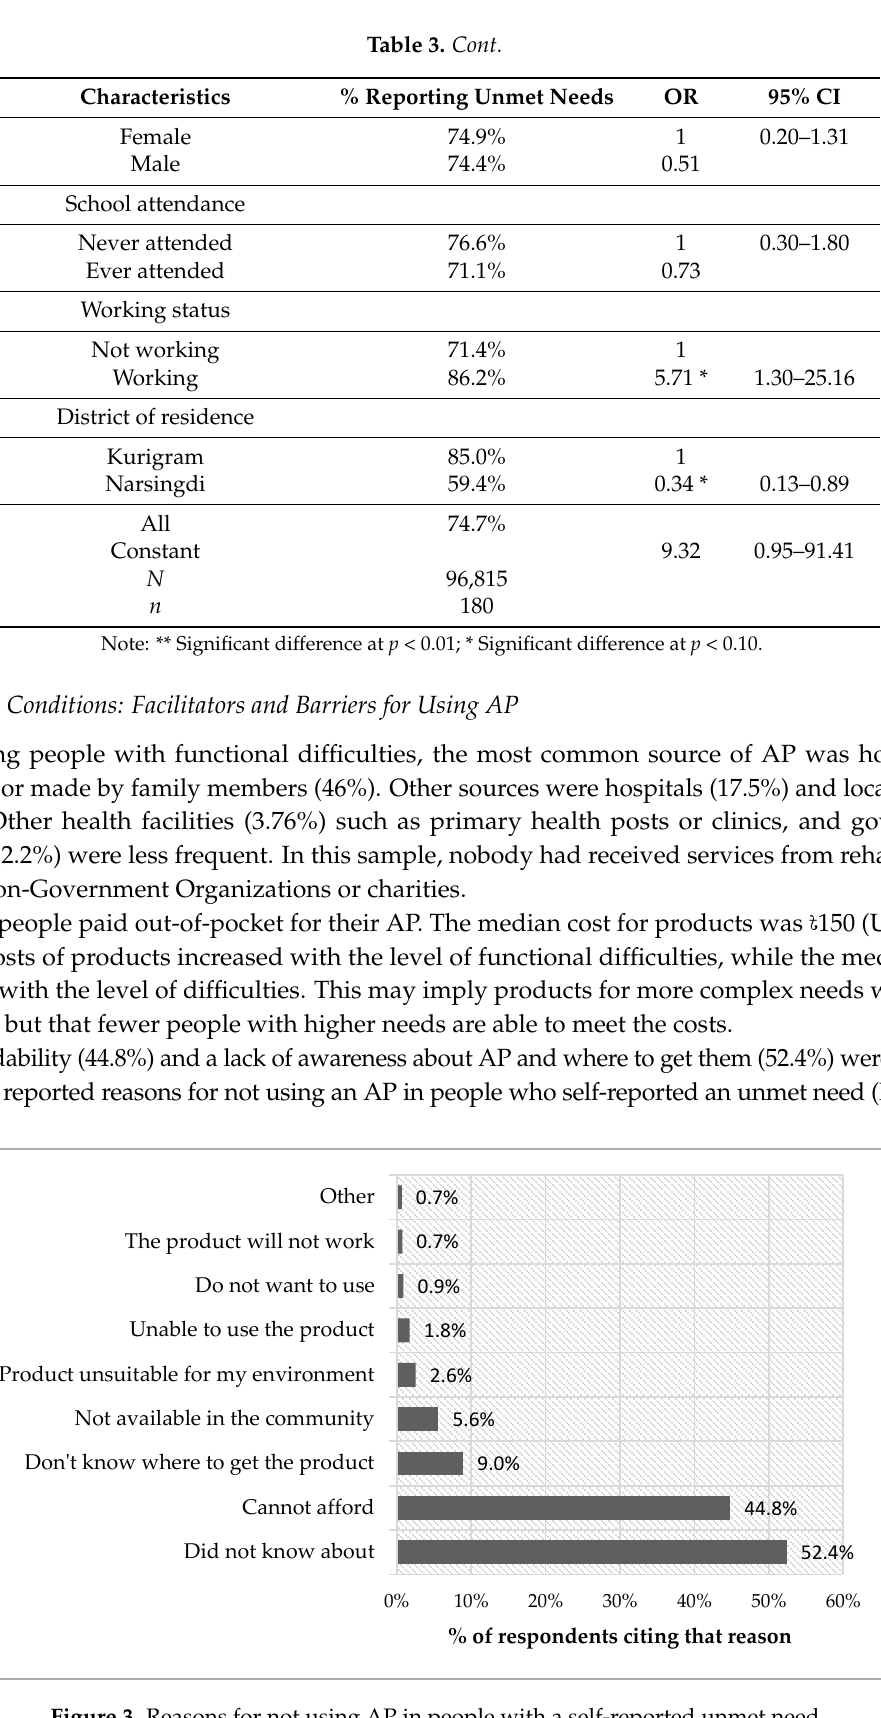
Figure 3. Reasons for not using AP in people with a self-reported unmet need